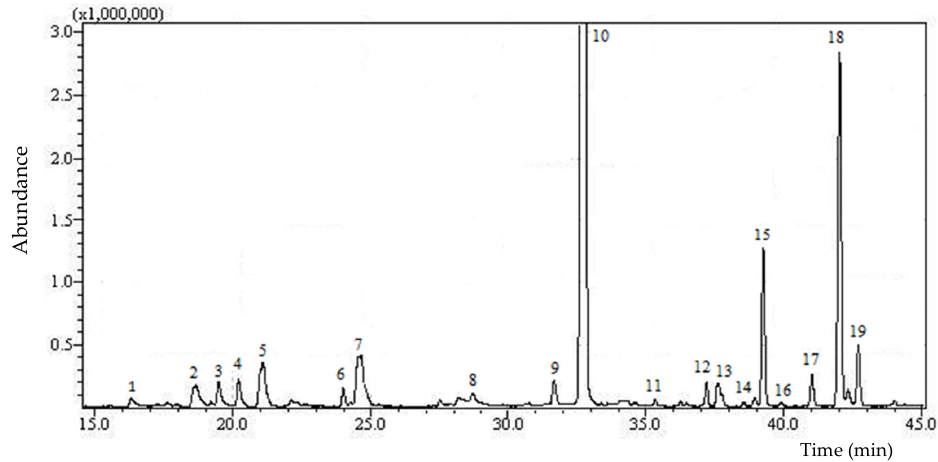
Figure 1. High-resolution gas chromatography mass-spectrometry (HRGC-MS) profile of volatile fraction of a monovarietal EVOO (Dolce Agogia) sample. Peak numbers correspond to the compounds listed in Table 3. Table 3. Volatile composition of monovarietal EVOO samples (% areas, mean values ± SD, n = 3). Number Compound Dolce